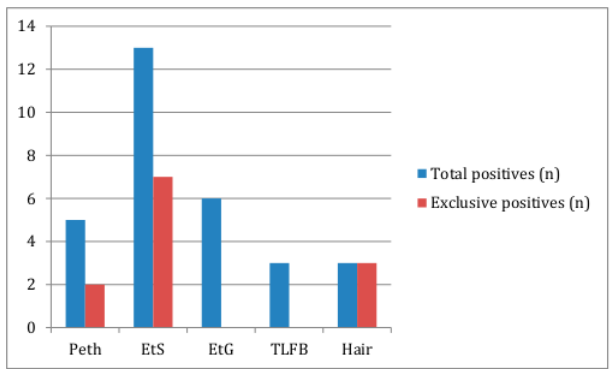
Figure 2. Dotplot showing Alcohol Use Disorder Identification Test (AUDIT) scores.